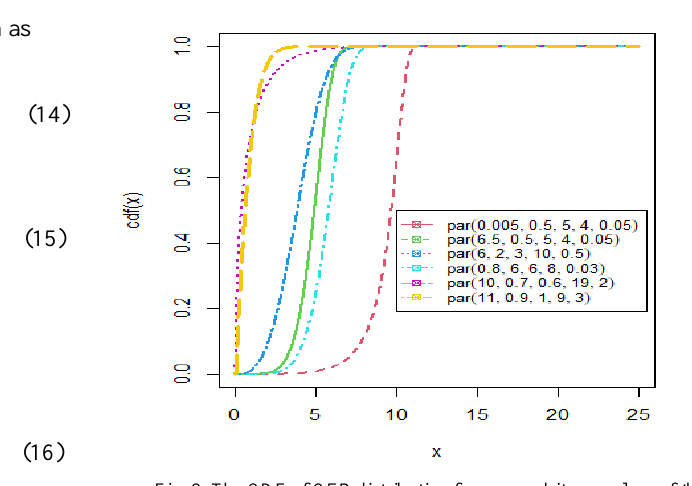
Fig. 2. The CDF of GEP distribution for some arbitrary values of the